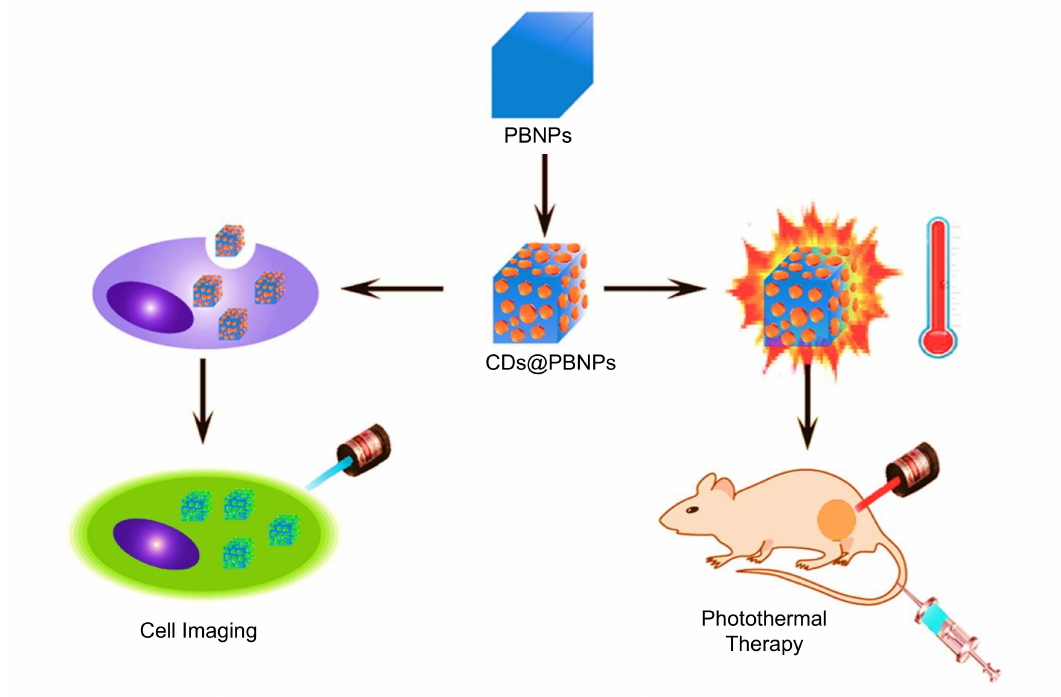
Figure 30. Display of CDs@PBNPs synthesis, and their contribution in photothermal therapy and cell imaging. Reprinted from [334], with permission from American Chemical Society, 2017. PBNPs: Prussian blue